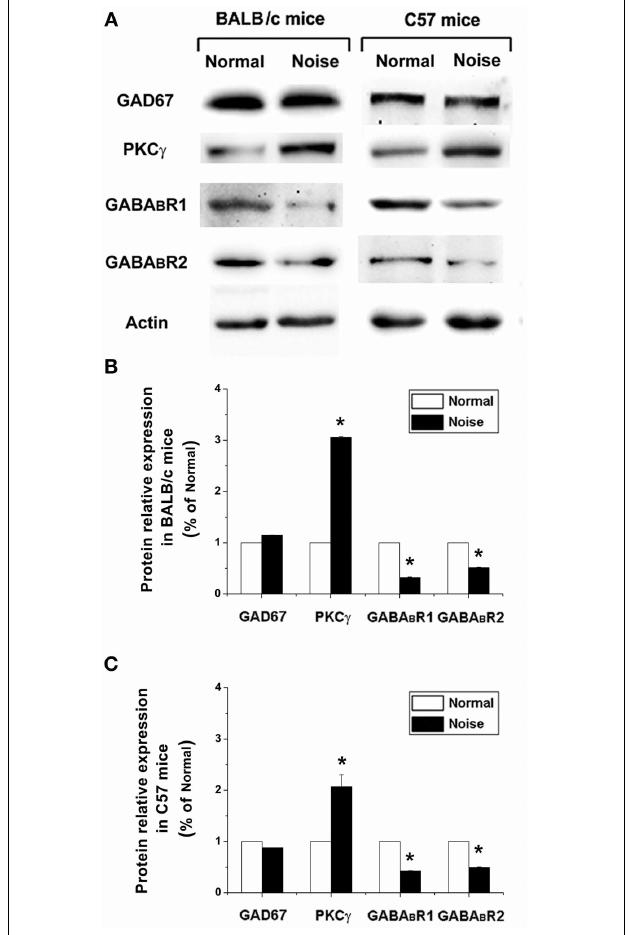
FIGURE 6 | The alterations of GAD67, GABA B R1, GABA B R2, and PKC γ at protein levels after noise exposure in BALB/c mice and C57 mice. (A) GAD67, GABA B R1, GABA B R2, and PKC γ protein levels detected by Western blotting. (B) The noise-induced changes of GAD67, GABA B R1, GABA B R2, and PKC γ expressions in BALB/c mice. (C) The noise-induced changes of GAD67, GABA B R1, GABA B R2, and PKC γ expressions in C57 mice. ∗ P < 0 .